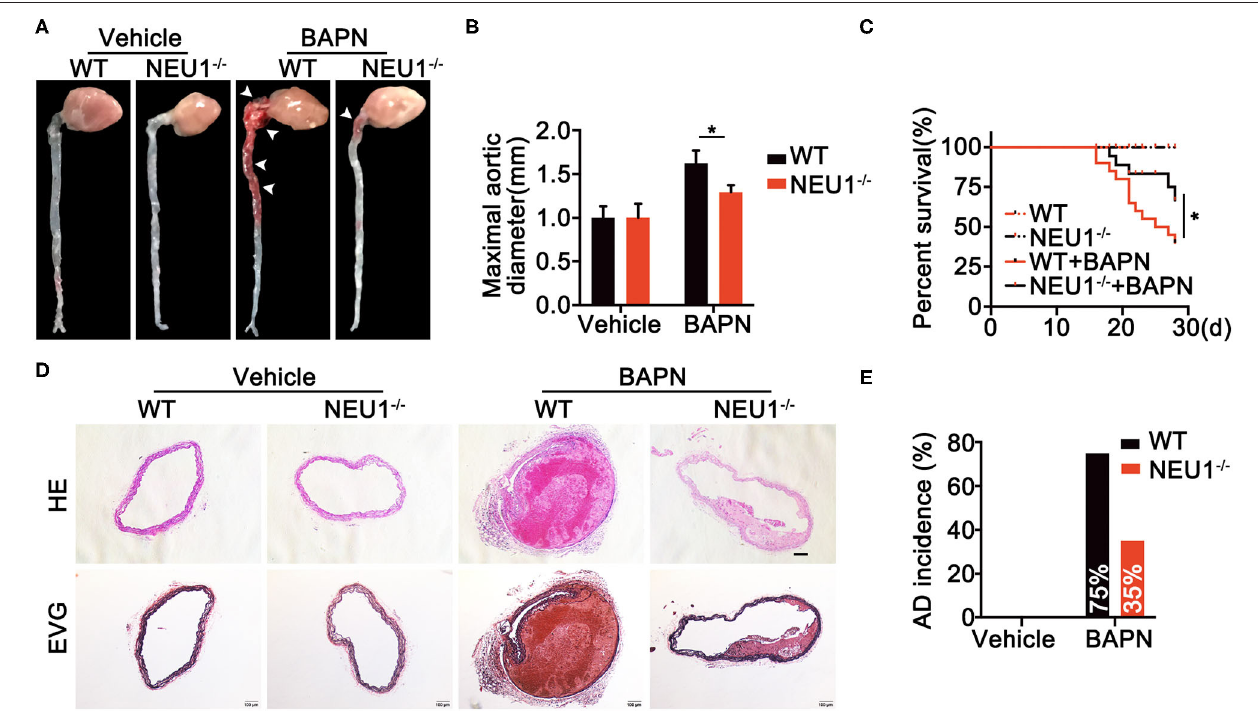
FIGURE 2 | Global NEU1 deletion mitigates BAPN-induced AD development. (A–E) , C57BL/6 wild-type and NEU1 KO mice were subjected to BAPN induction. (A) Representative macrographs of the aortas. (B) Maximal aortic diameter ( n = 8, * p < 0.05). (C) Kaplan–Meier survival analysis of indicated groups ( n = 20, * p < 0.05). (D) Representative HE and EVG staining of the aorta. (E) AD incidence in indicated groups ( n = 20). AD, aortic dissecting; BAPN, β -aminopropionitrile monofumarate; EVG, Elastic Van Gieson’s staining; HE, hematoxylin and eosin; KO, knockout; NEU1, neuraminidase